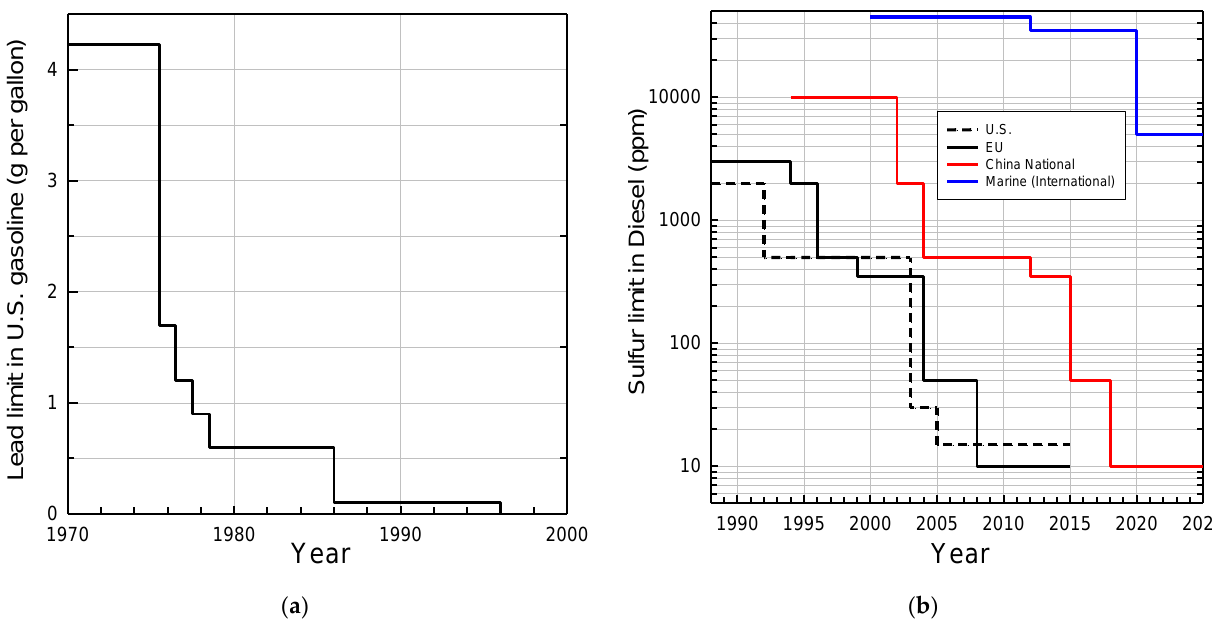
Figure 1. Reductions in regulatory limits for: ( a ) lead added to U.S. gasoline; ( b ) sulfur in diesel in the U.S., EU, China, and in marine fuel. The U.S. voluntary standard for lead from 1958 to 1975 was 4 cm 3 tetra-ethyl lead per gallon which equates to 4.23 g Pb per gallon. The industry average use was approximately 2.4 g Pb per gallon in the 1950s and 1960s. The EPA required the availability of one grade of unleaded gasoline by 1974 to protect catalytic converters introduced in 1975. Limits from 1975 to 1986 were specified based on “pool averaging” allowing refiners to average over all grades of gasoline, including unleaded. In 1986 pool averaging was discontinued and the limit referred to leaded gasoline. The addition of lead to U.S. gasoline for road vehicles was banned in 1996 (https://www.epa.gov/history/epa-history-lead, accessed on 31 January 2022). Sulfur data were taken from https://www.transportpolicy.net/topic/fuels/, accessed on 31 January